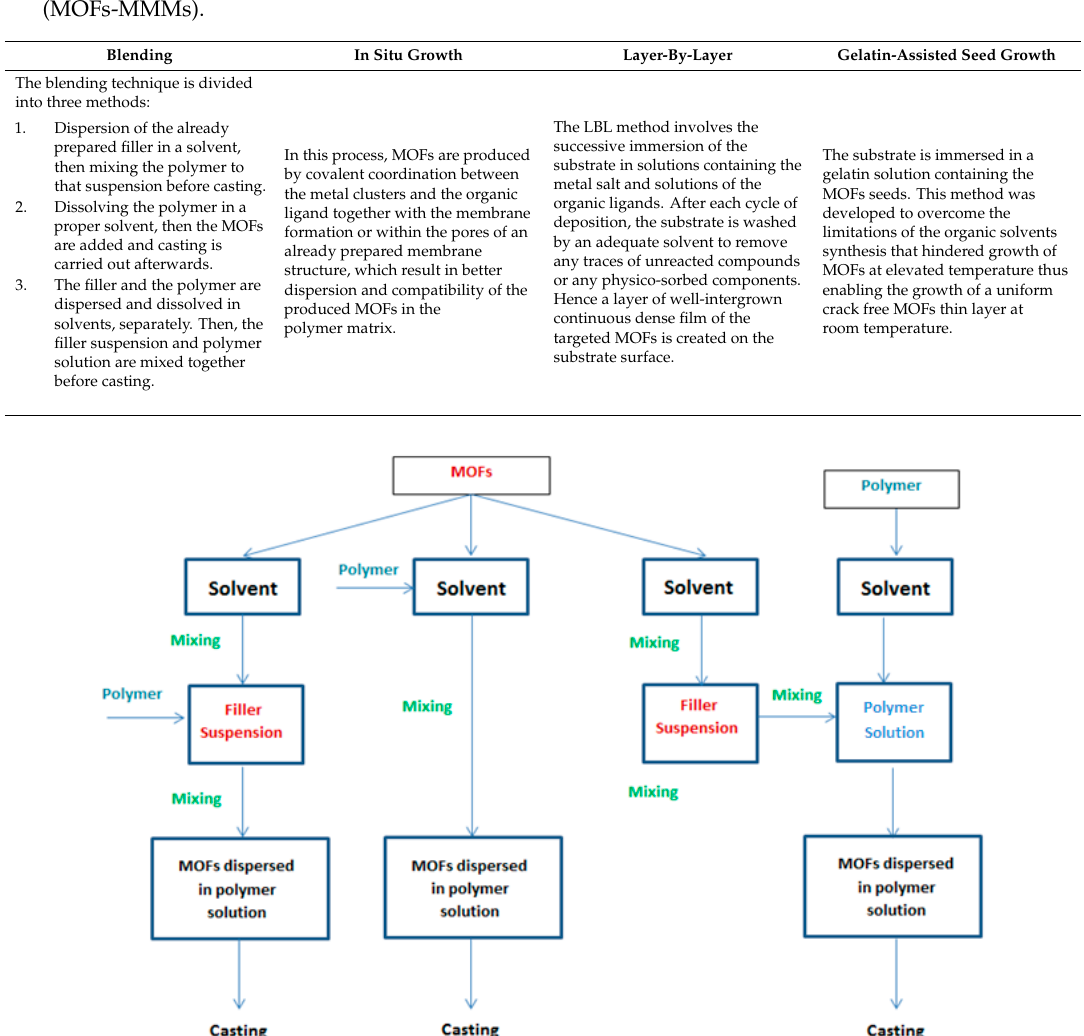
MOF S Figure 1. Schematic diagram of the different routes followed in the blending method to synthesis MOF S -MMMs.